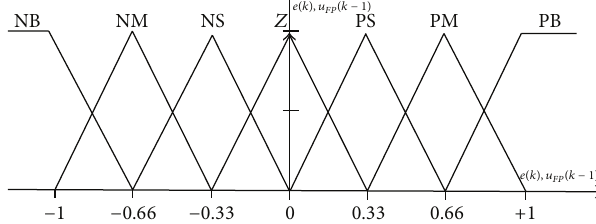
Table 2: 7 × 7 rule base table for fuzzy-PID